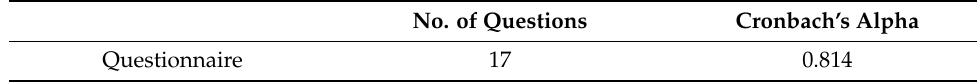
Table 1. Cronbach’s α